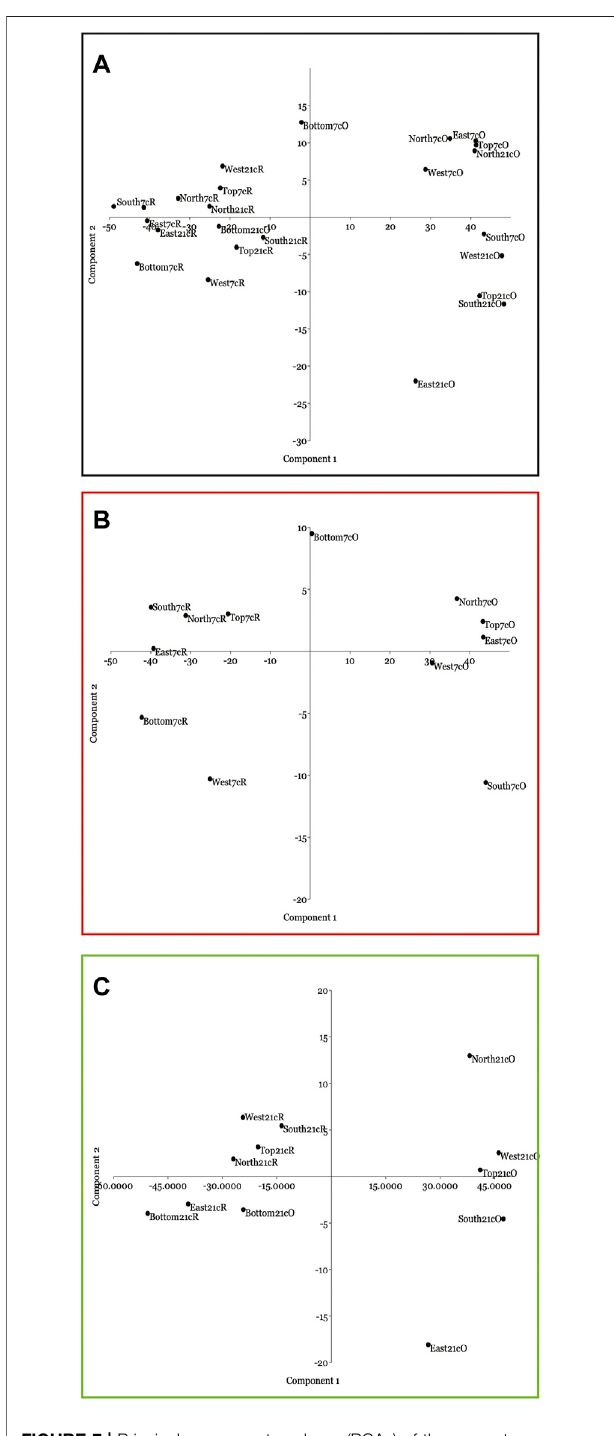
FIGURE 7 | Principal component analyses (PCAs) of the percentage cover of the coralligenous side, showing the scatter plot with the Component 1 and 2 axes. (A) PCA of all the sides, both original (O) and after the canopy removal (R); (B) only CBR2_3_7c; (C) only CBR2_4_21c.